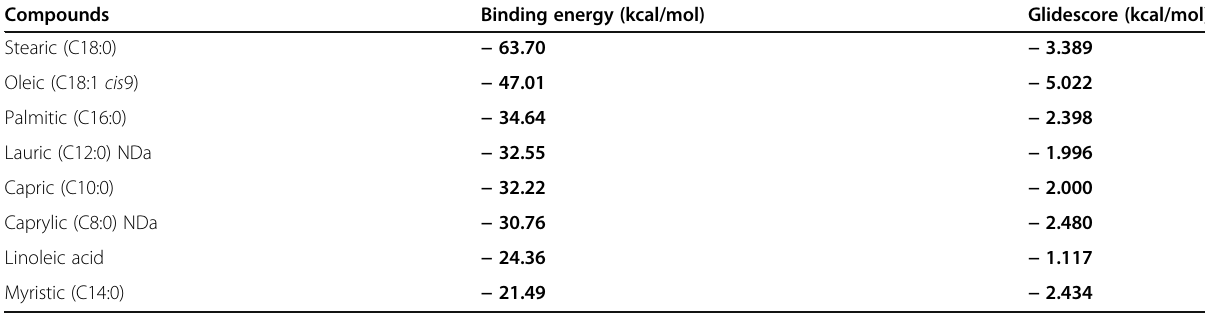
Table 2 The binding energy and glide score obtained in the molecular docking studies Compounds Binding energy (kcal/mol) Glidescore